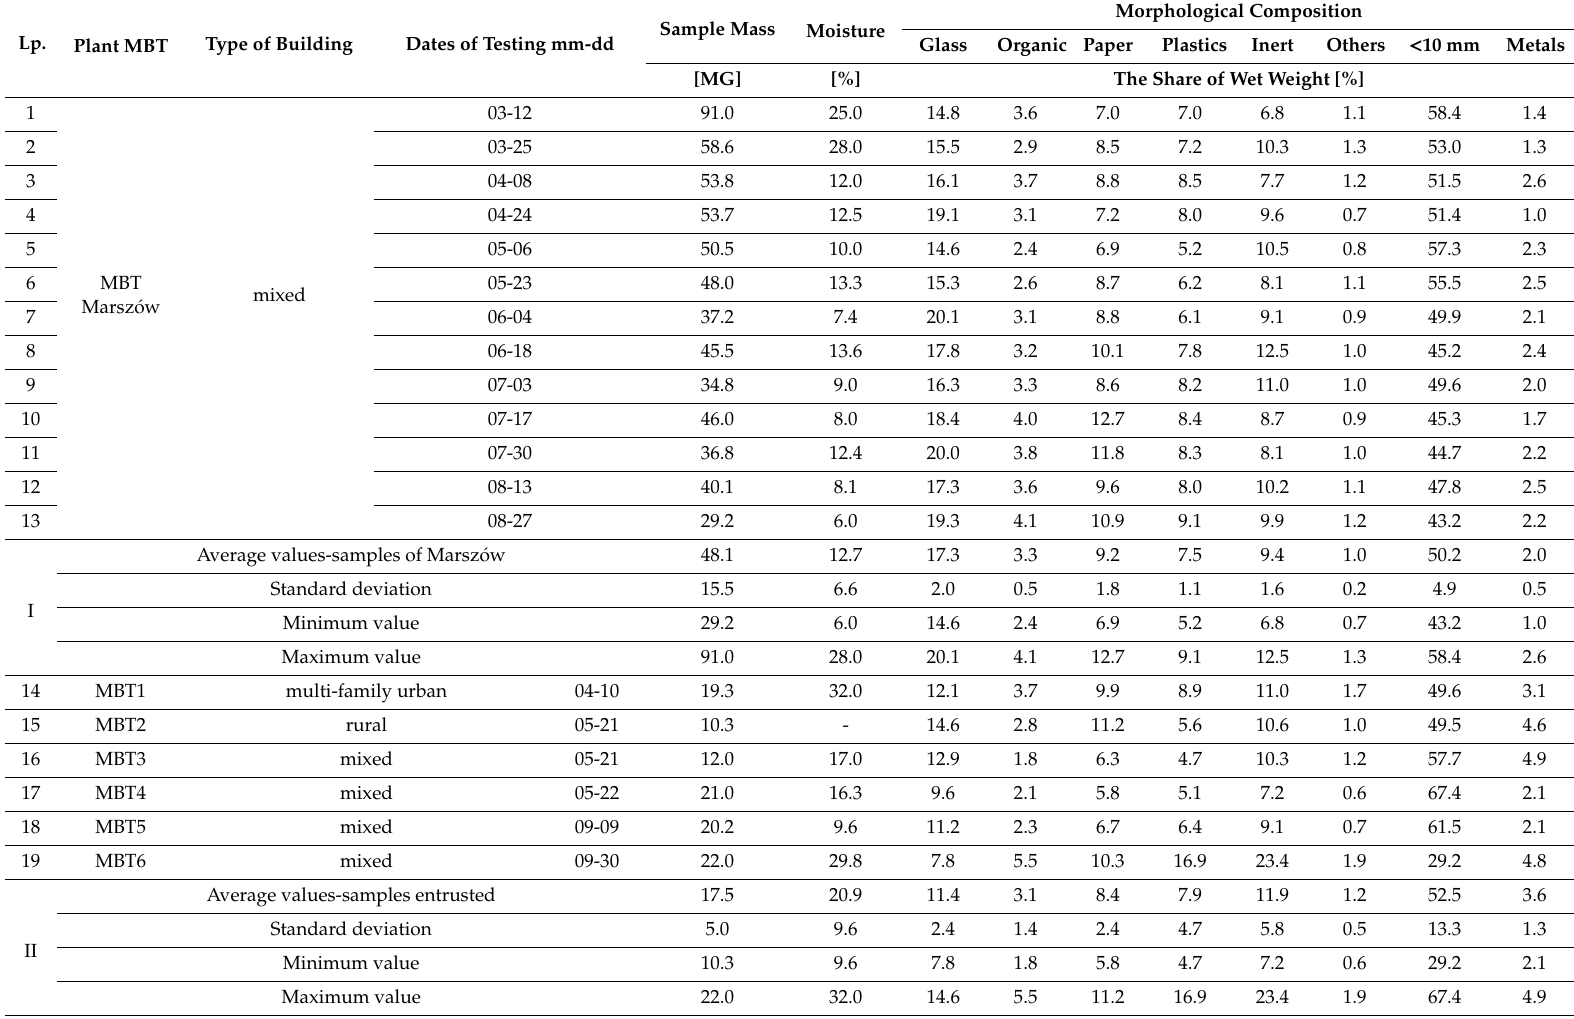
Table 1. Types of plants and characteristic of tested